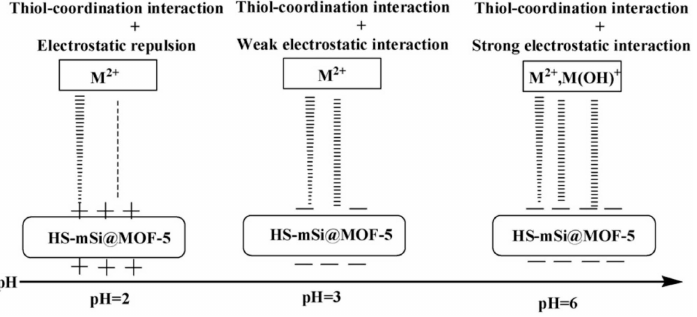
Figure 7. Schematic diagram of the strength of HS-mSi@MOF-5 on metal ions at different pH values. Reprinted with permission from Ref. [99]. Copyright 2016,